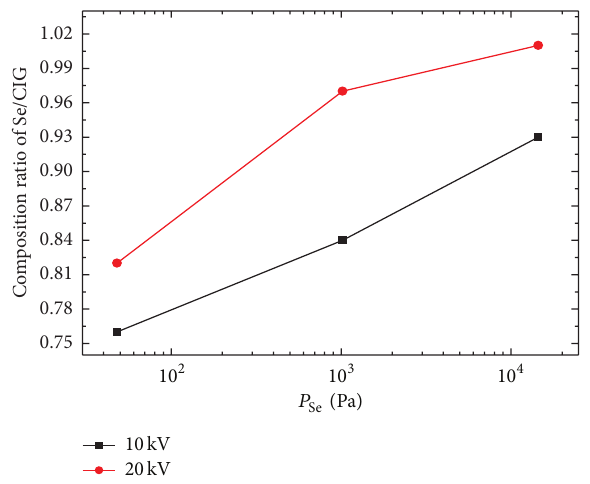
Figure 2: Composition ratio of Se/CIG with various selenization